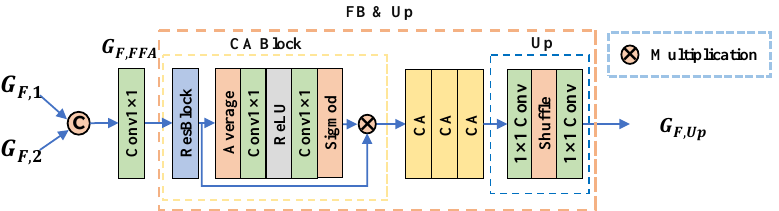
Figure 7. Detailed illustration of Feature Blending and Upsampling module. This module consists of a CA block and an Up block. Average represents a global average pooling operation and Shuffle represents the shuffle pixel operation, respectively.